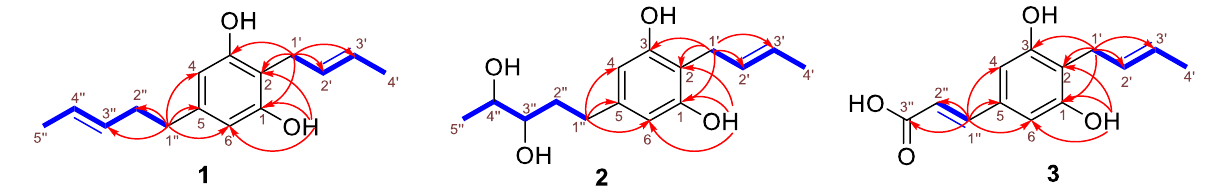
Figure 4. Key HMBC (red arrows) and 1 H- 1 H COSY (blue-bold) correlations of compounds 1 – 3.